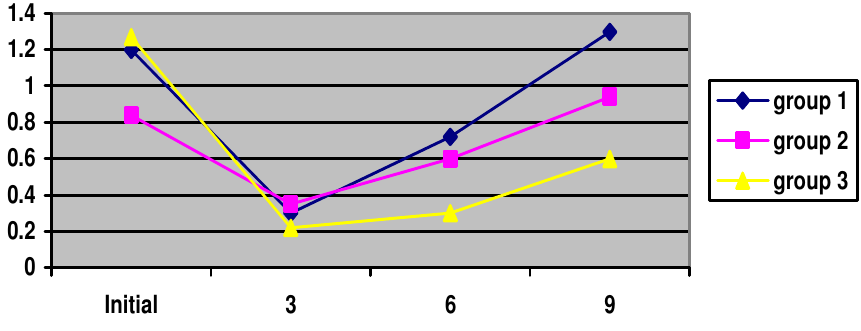
FIGURE 4 . The change of pain scores of patients in three groups in time (months).